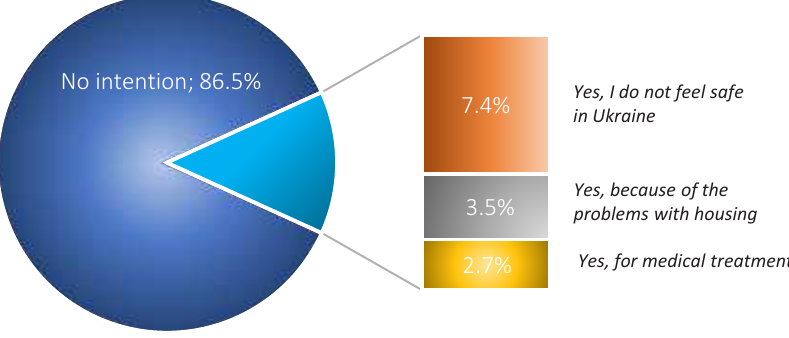
Figure 9. Migration intentions to leave Ukraine among IDPs in the Pidberiztsivska community, % of respondents